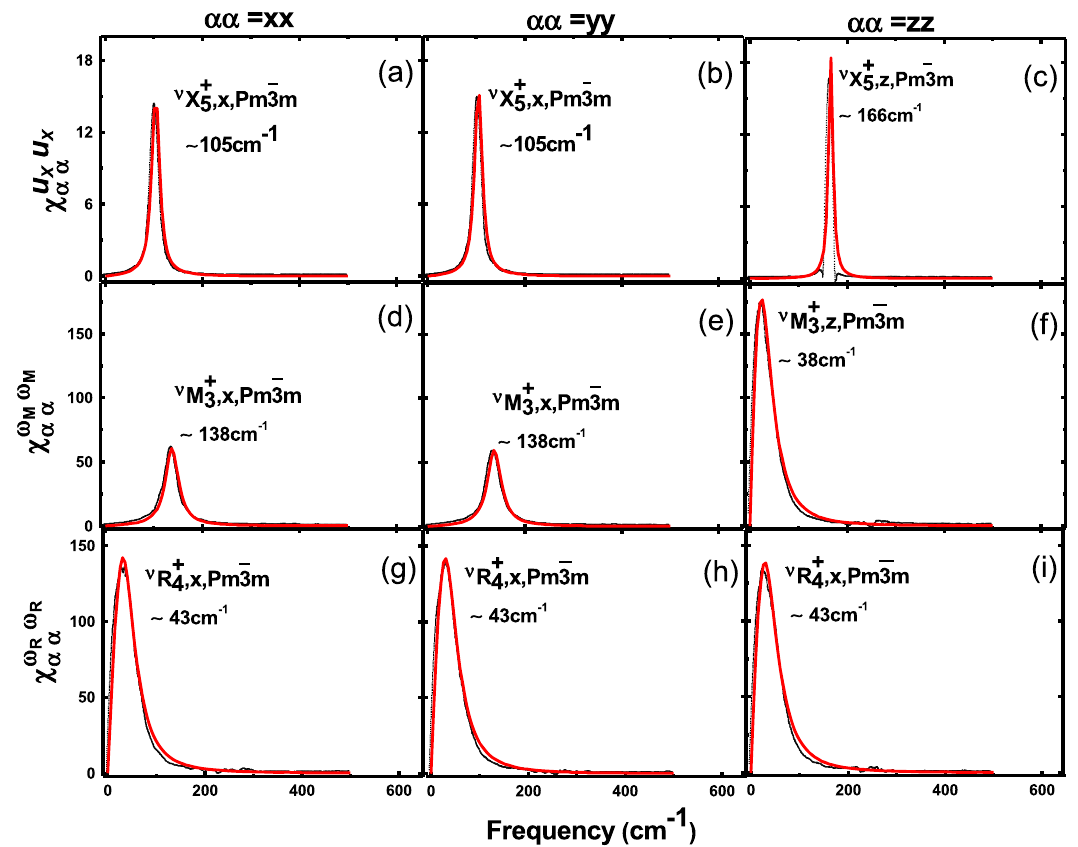
Fig. 2 Frequency dependence of the imaginary part of the χ AA αα ν ð Þ “ susceptibilities ” in our BFO system subject to hydrostatic pressure, for A =